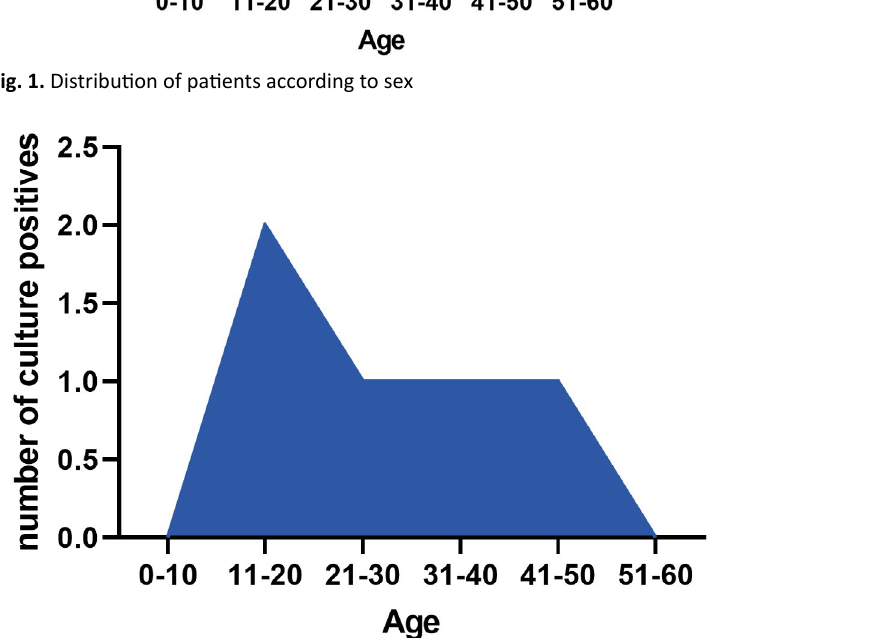
Fig. 2. Distribution Of Patients According To